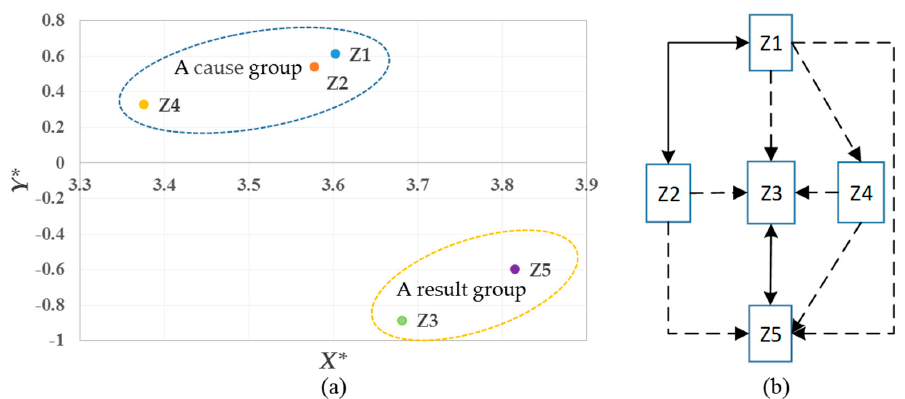
Figure 5. Cause and effect diagrams among main criteria. ( a ) The causal attributes of all main criteria and ( b ) the significant relations between main criteria